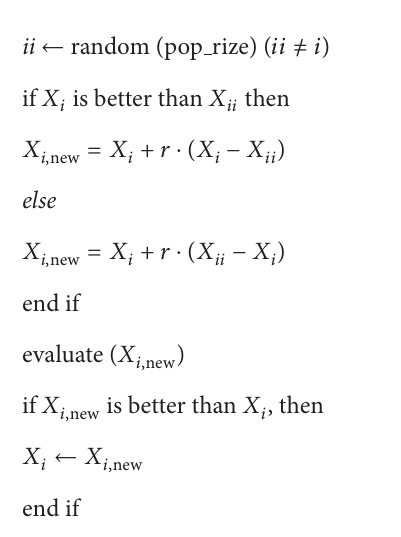
Figure 1 show the flowchart of TLBO